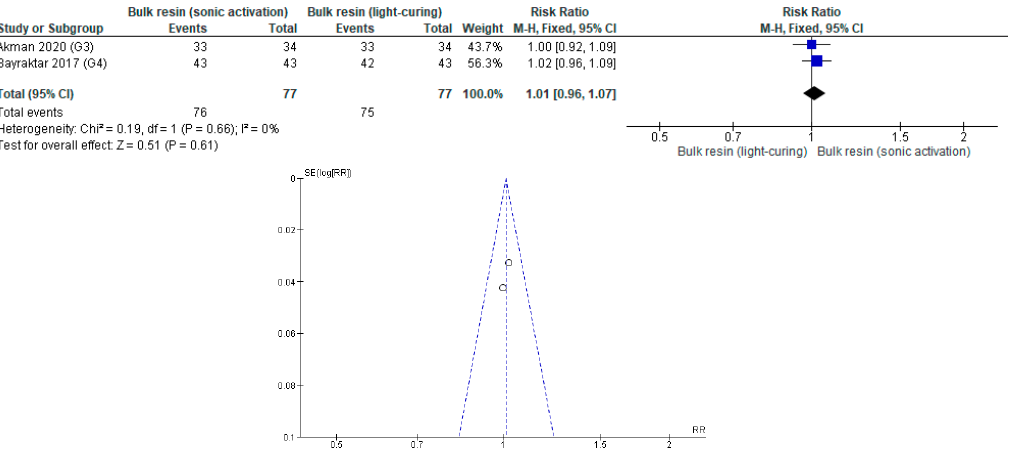
Figure A15. Adequate Marginal Adaptation: Bulk Resin (with Sonic Activation) versus Bulk Resin (Two-Step Technique).